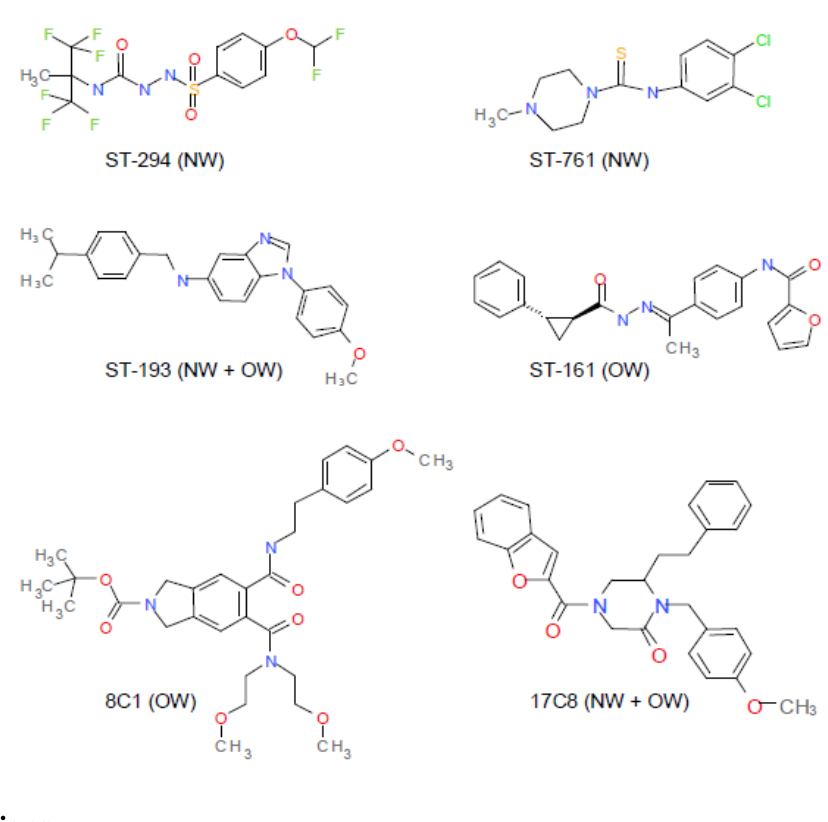
Figure 5. Chemically distinct classes of arenavirus-specific fusion inhibitors. Compounds from SIGA Technologies are indicated with the ST prefix [15,16,85,86] and 8C1 and 17C8 were described at The Scripps Research Institute [17]. All lead compounds were identified through high-throughput screening for inhibition of arenavirus infection or GPC-mediated entry. The compounds all bind to a common site on prefusion GPC and act through the pH-sensitive SSP-G2 interface, but differ in their specificities for NW and/or OW arenaviruses (as